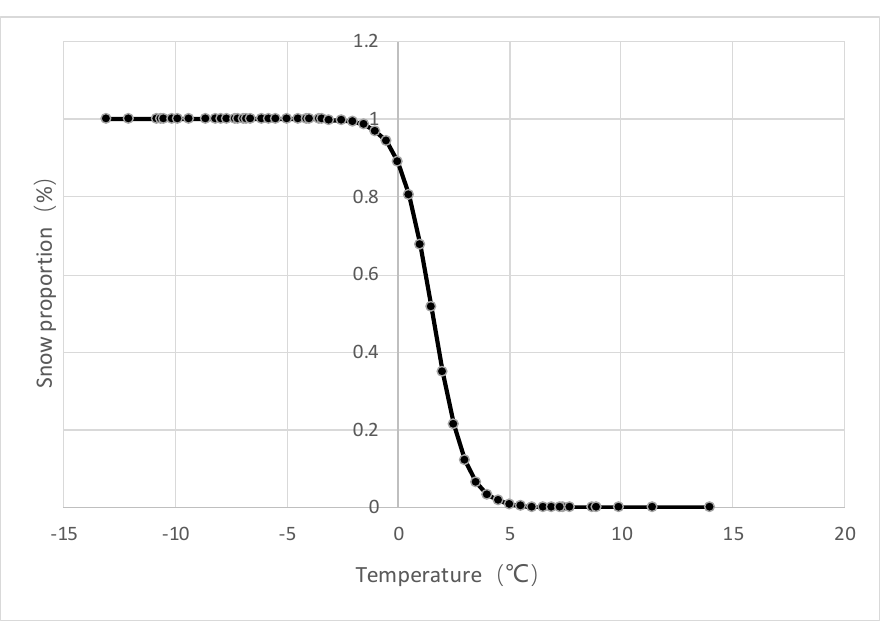
Figure 3. Diagram of the relationship between the snowfall ratio and average daily temperature.